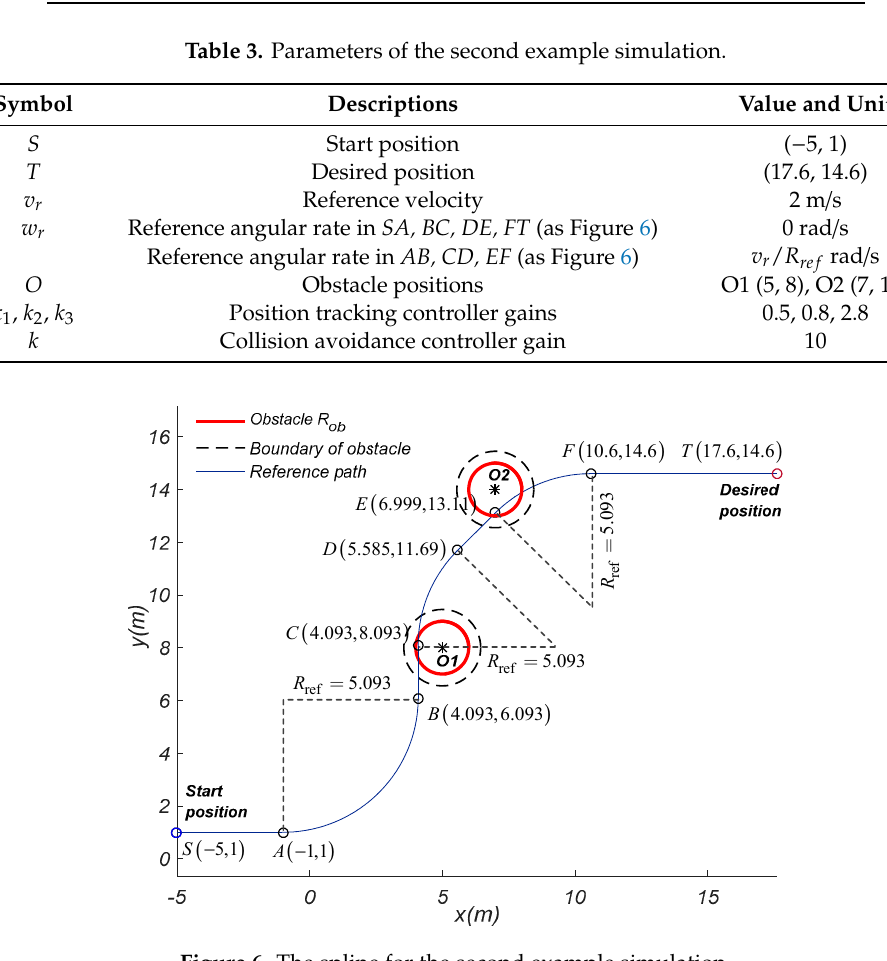
Figure 6. The spline for the second example simulation.